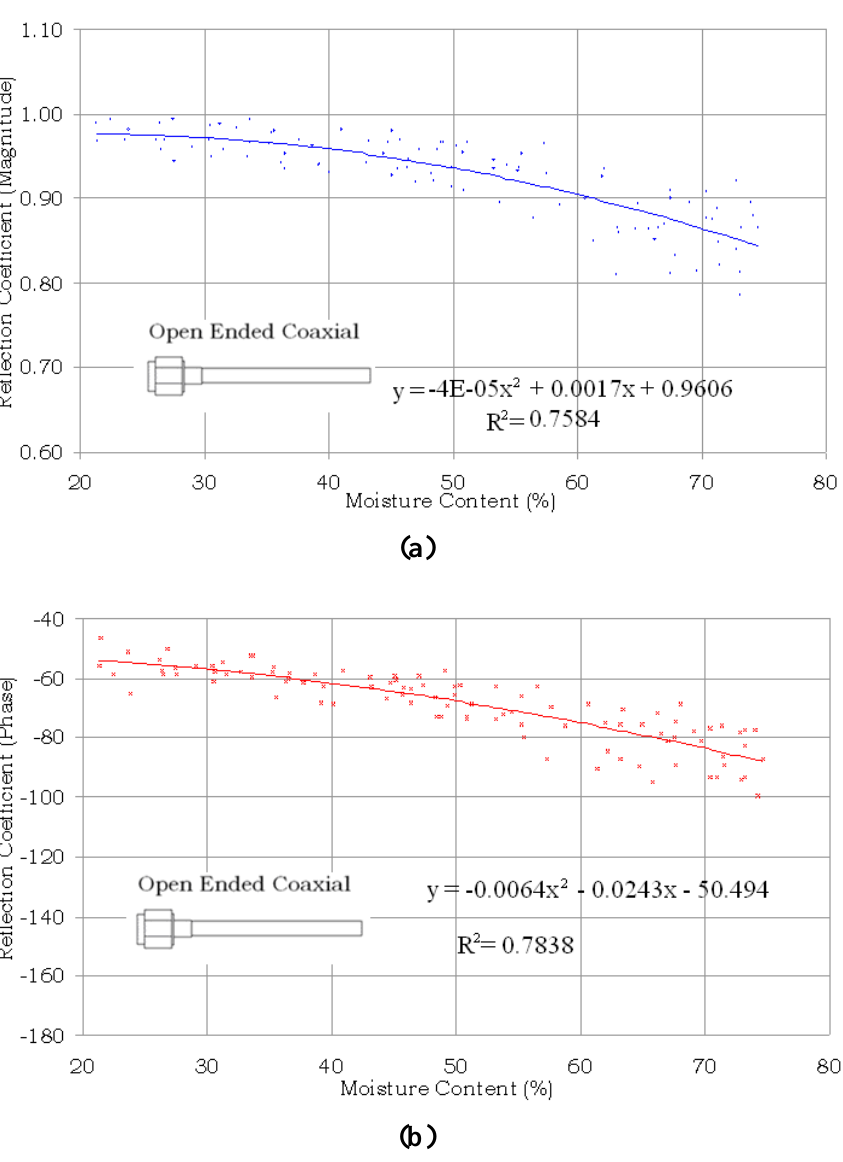
Figure 4. Variation in magnitude and phase of S coaxial sensor. (a) Magnitude; (b)